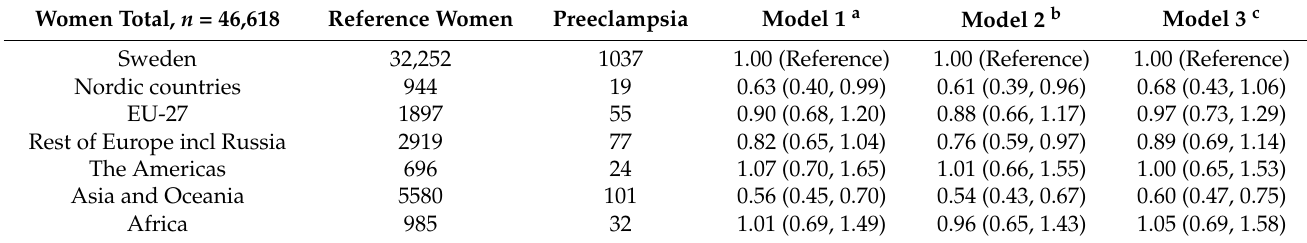
Table 3. Risk ratios (RR) and 95% confidence intervals (CI) for gestational diabetes and preeclampsia by maternal region of